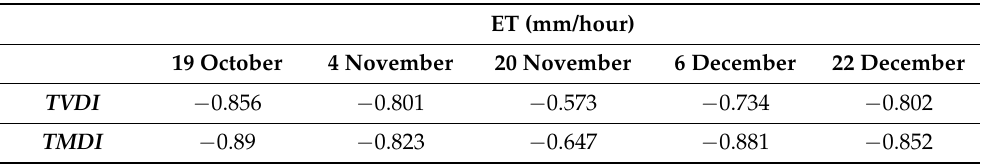
Figure 6. SEBAL-Derived ET over Yun-Chia-Nan on 19 October, 4 November, 20 November, 6 December, and 22 December 2014. Table 3. Correlation between TMDI / TNDI and SEBAL-derived ET over Yun-Chia-Nan on 19 Octo-